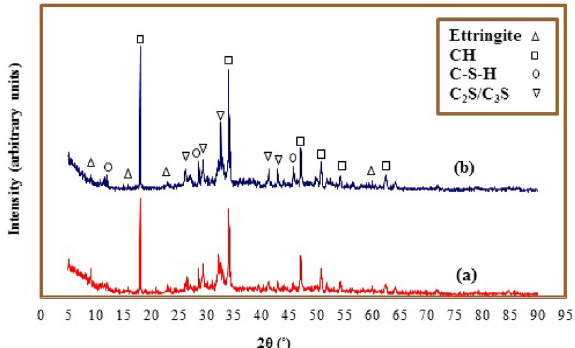
Figure 5. The XRD patterns of ( a ) neat cement and ( b ) the cementitious composite loaded with BN–Fe 3 O 4 nanocomposite (BN–F5) at 28 days of hydration.